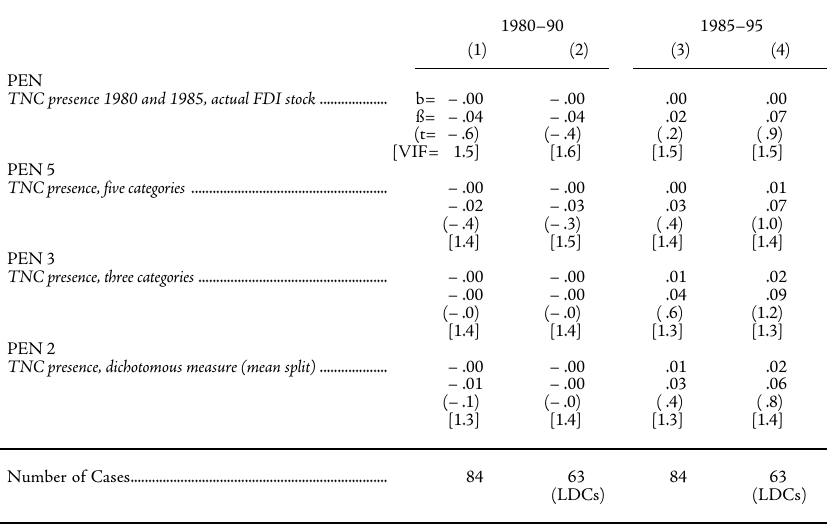
Table 1b – Results for alternative measures of TNC penetration in equations (1)–(4) of Table